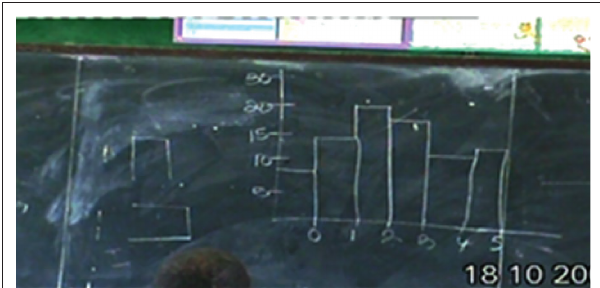
FIGURE 10: Bar-like graph of the number of children in different